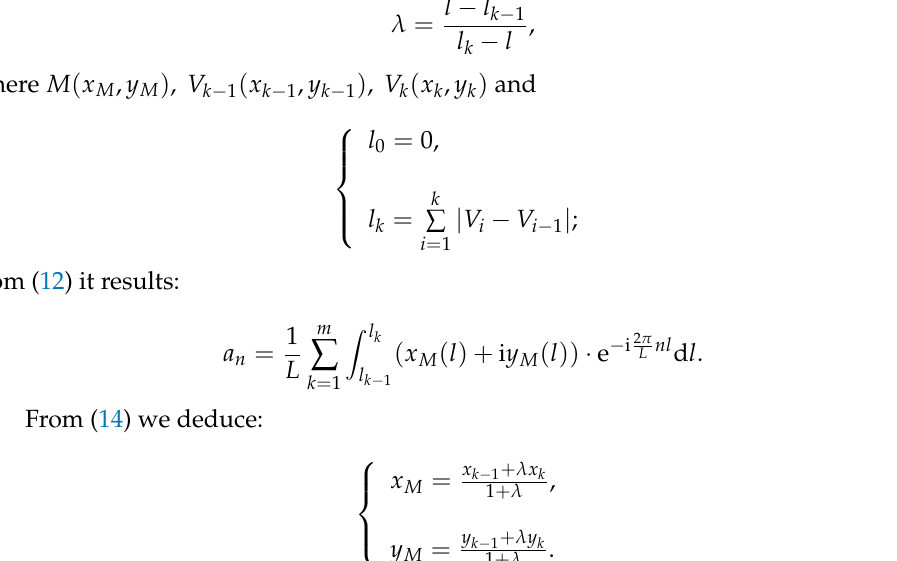
Figure 8. Parametric representation of a segment.